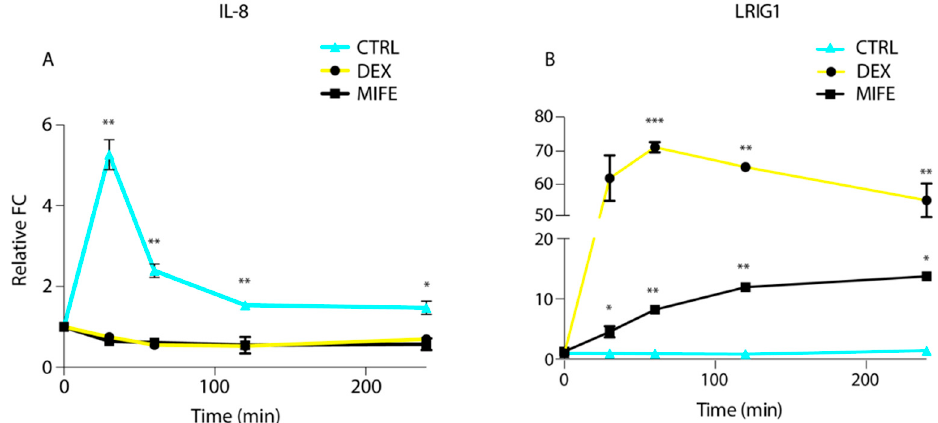
Figure 4. Comparison of gene expression level of EGFR positive (IL-8) and negative (LRIG1) feedback loops following dexamethasone (DEX) and mifepristone (MIFE) treatment in cetuximab resistant (CXR) resistant cells. Caco-2 CXR cells were pretreated with DEX (1 µM) or MIFE (1 µM) and stimulated with a combination of cetuximab (CTX,2 µg/mL) and EGF (20 ng/mL) at different time points (30, 60, 120 and 240 min). qPCR analysis was performed for IL-8 and LRIG1 feedback loops. ( A ) IL-8 gene expression level following DEX or MIFE treatment shows an immediate decrease in gene expression (after 30 min), maintained during the whole-time (up to 8 hours) compared to time 0. CTRL showed a five folds increase in gene expression level after 30 min from CTX and EGF treatment. ( B ) Increase in LRIG1 gene expression following DEX or MIFE treatment. Notably, Caco-2 CXR following DEX treatment displayed a burst in LRIG1 expression with seventy folds gene expression increase when compared to time zero. Statistical test of triplicated data was determined by multiple t-test, using the Holm-Sidak method, with alpha = 5%. Each row was analyzed individually, without assuming a consistent SD. *** p < 0.0005, ** p < 0.01, * p < 0.05.